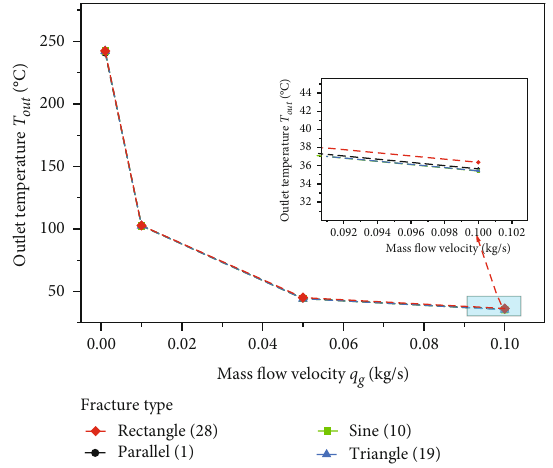
Figure 7: Relationship between fl ow rate and outlet